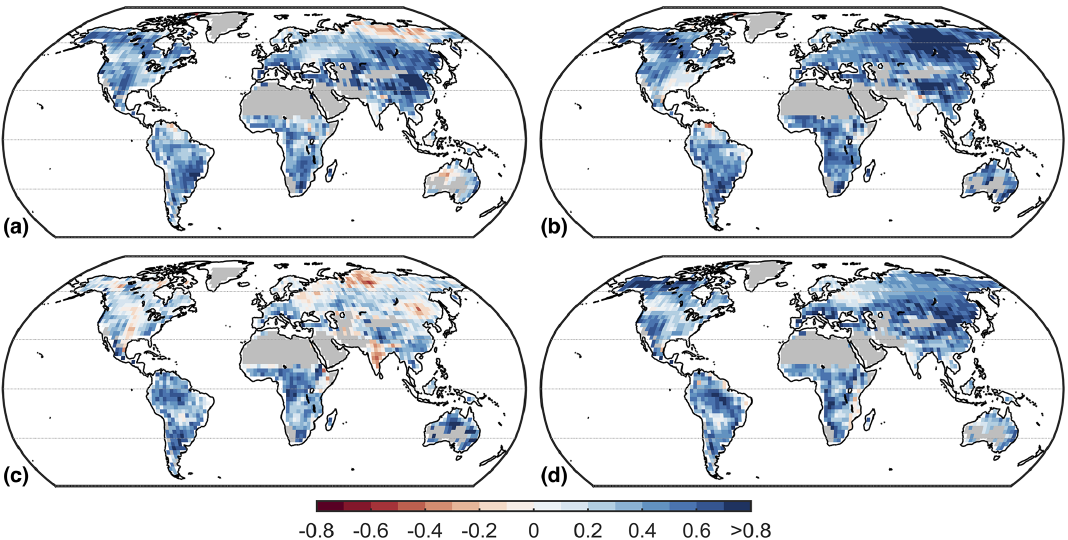
Figure 7. Pearson correlation at each grid cell between the average NWL and the nocturnal near-surface air temperature of climate mod- els. Data correspond to the period from 1976 to 2005 from historical simulations. Correlations are computed separately for each season: (a) December–February, (b) March–May, (c) June–August, and (d) September–November. Desert regions and Greenland are masked for